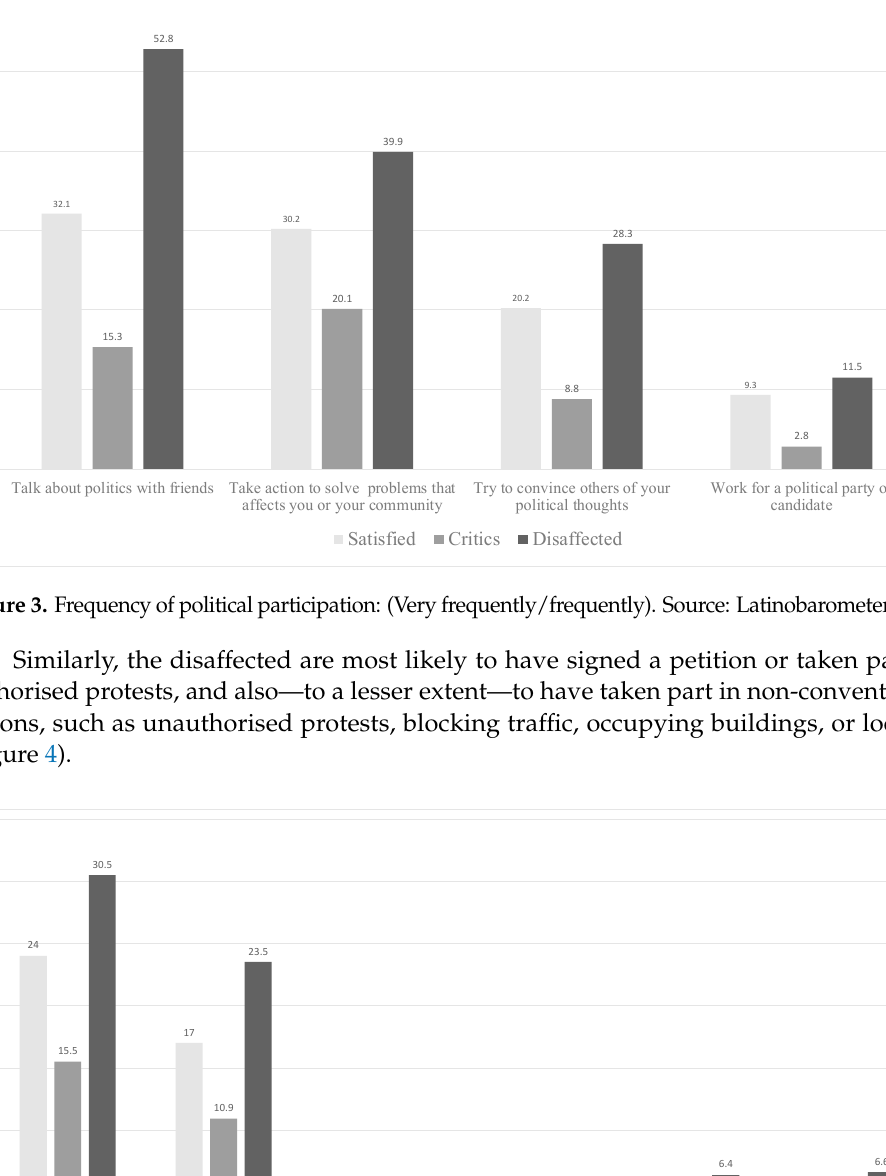
Figure 5. Political actions: (Have ever done). Source: Latinobarometer 2020.